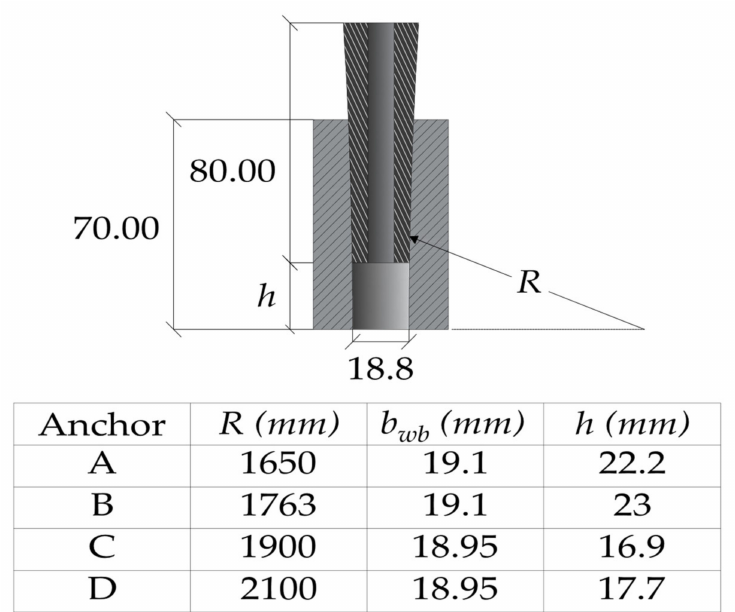
Figure 10. Split wedge anchorage proposed by Al-Mayah et al. [24], with a circular profile between the barrel and wedges. The table reports the adopted values of R , b wb , and h for each anchorage configuration (dimensions in